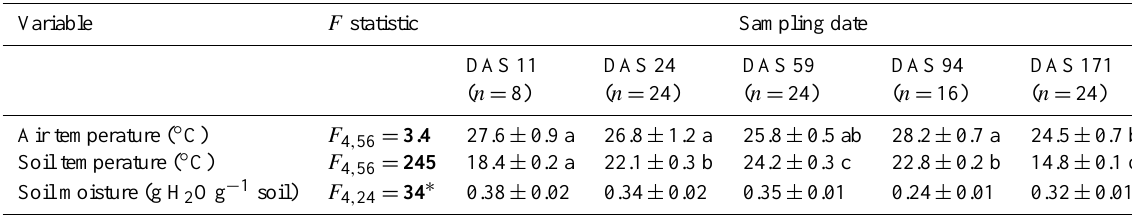
Table 1. Environmental and soil (0–10cm depth) variables by sampling date (mean ± SE).